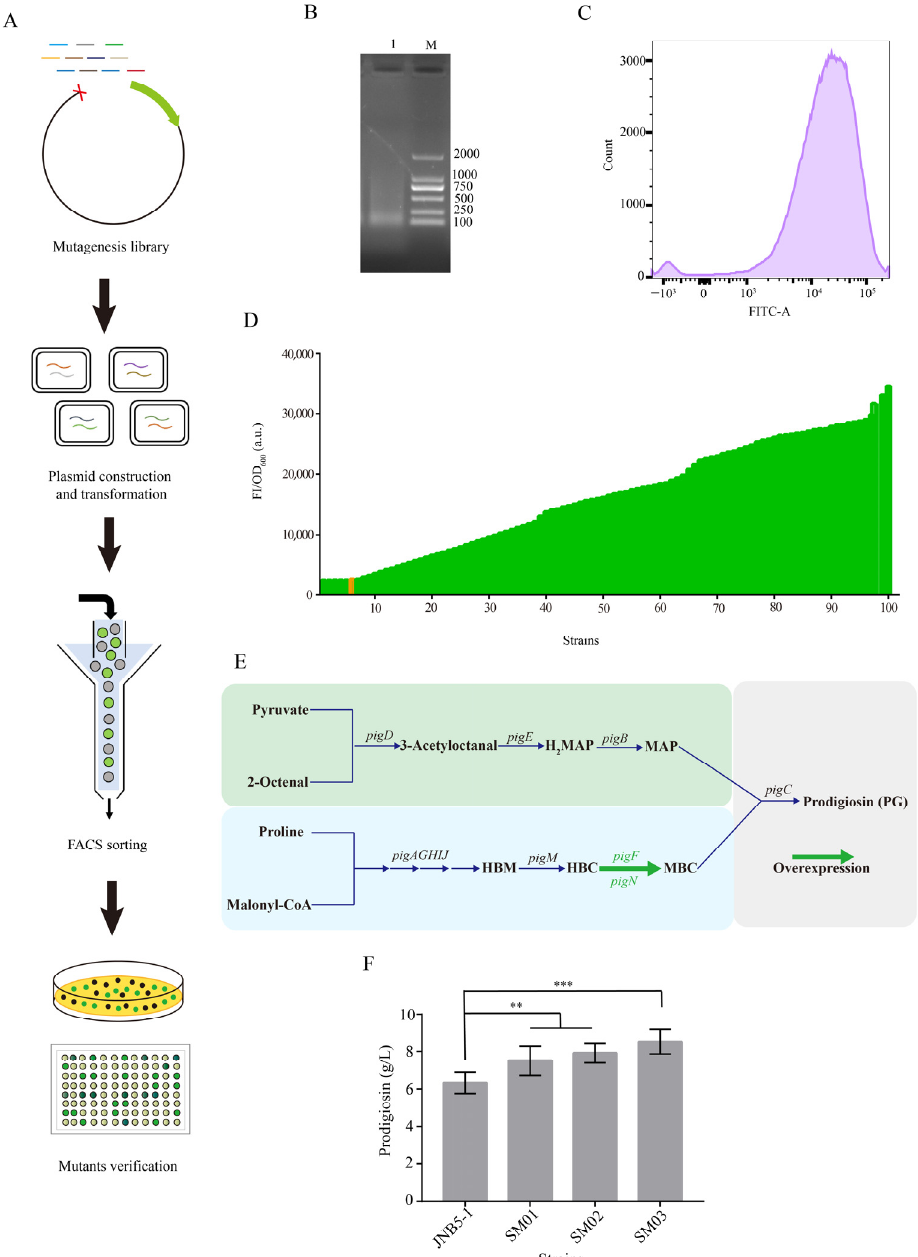
Figure 5. Optimization of prodigiosin synthesis using the strong constitutive promoter screened from S. marcescens . ( A ) Workflow of construction and screening of the constitutive promoter. ( B ) Gels of randomly interrupted genomes of S. marcescens JNB5-1. M: Marker DL2000. Lane 1: Random interruption of the S. marcescens JNB5-1 genome. ( C ) FACS sorting of promoters with enhanced fluorescence intensities from S. marcescens JNB5-1. ( D ) Strength analysis of the P SM variants using